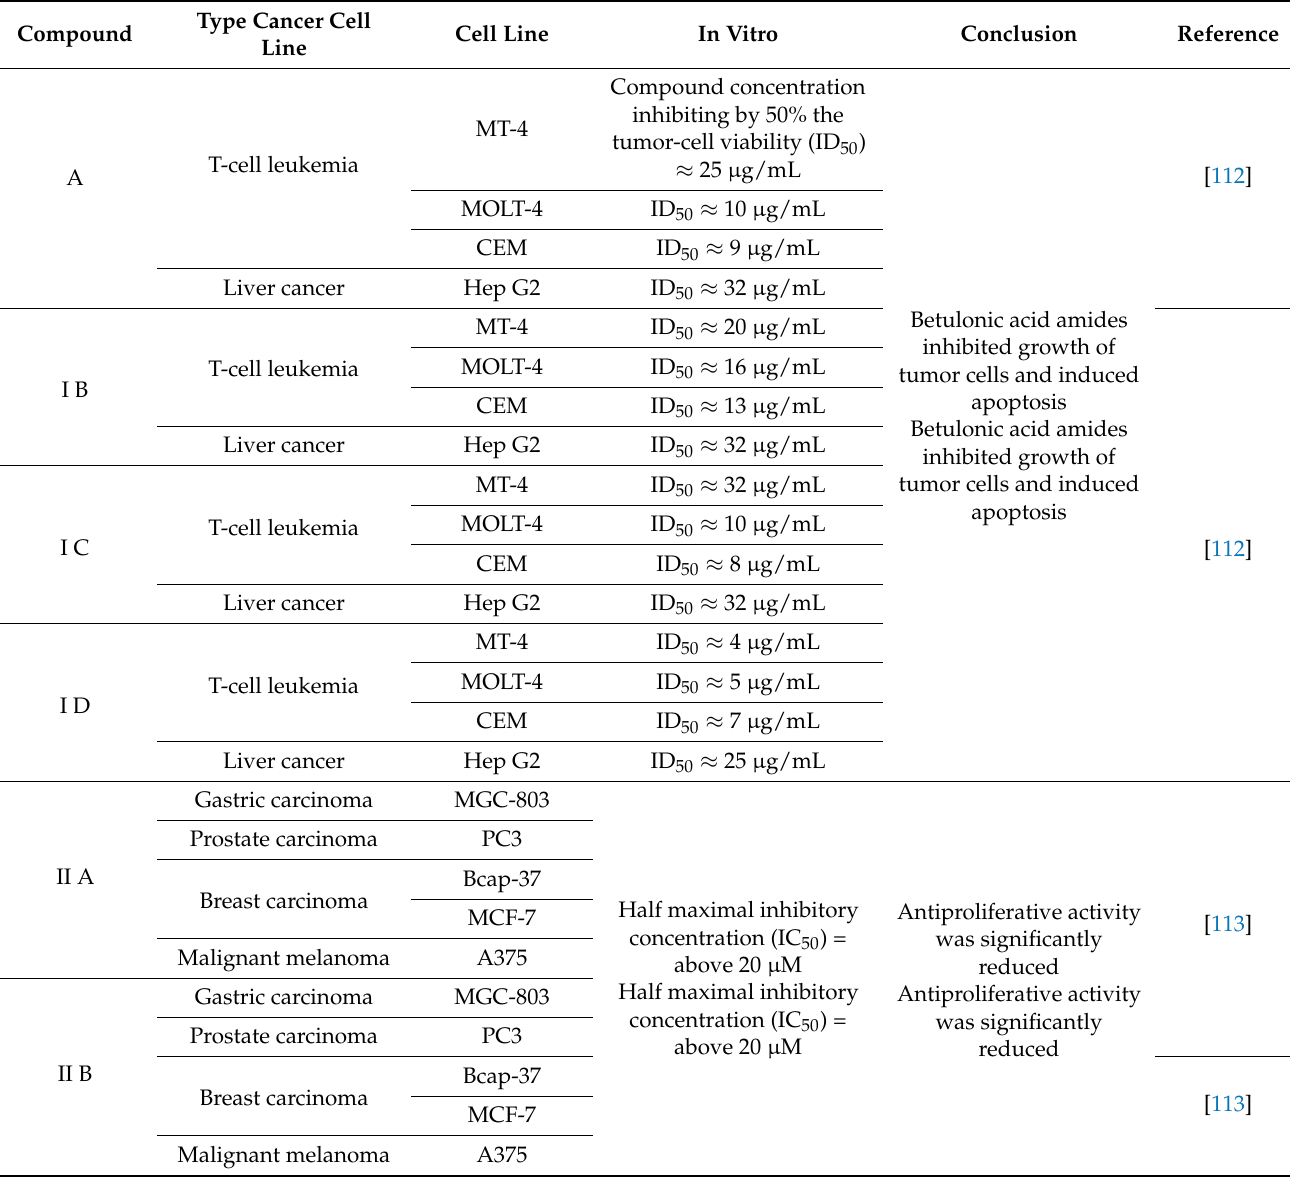
Table 2. Role of betulonic acid derivatives among various cancer cell